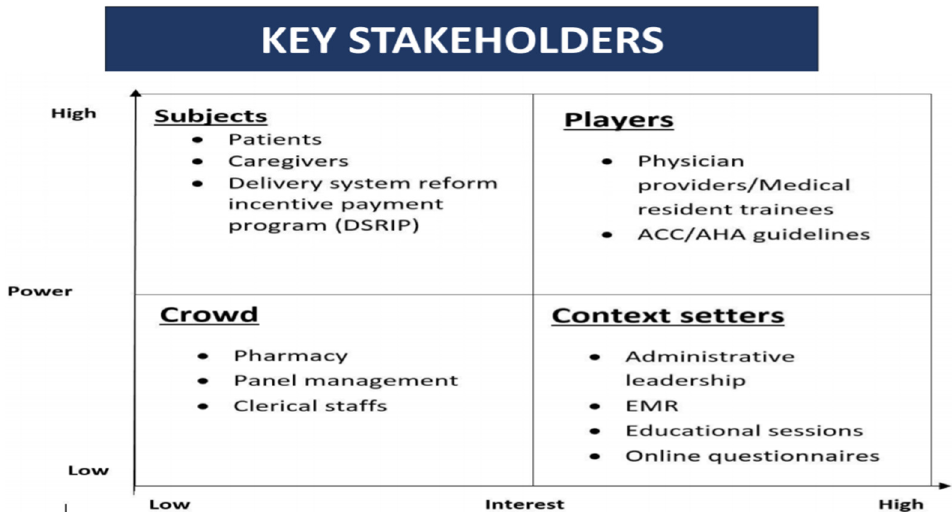
Figure 1. Illustration of key stakeholders in the order of interest in the study and power to contribute to the study.